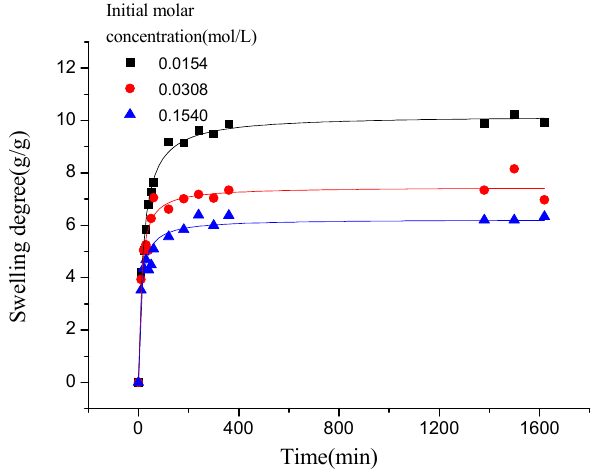
Figure 9. The swelling kinetics of γ -PGA/ ε -PL hydrogels in CaCl 2 solution.